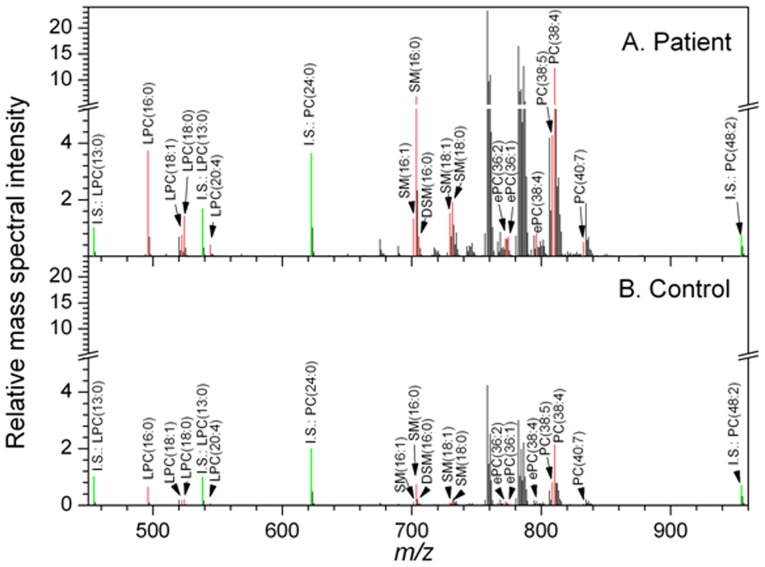
Mass spectra of phosphocholine-containing lipids (Pre-184 positive mode, including biomarker species.A: Spectra of 15 selected apparent lipid species in a representative patient with prostate cancer. B: Spectra of 15 selected apparent lipid species in a representative male control. Spectral intensities were normalized to that of internal standard LPC(13∶0). The intensities of phosphocholine-containing internal standards (I.S.) are indicated in green. The intensities of the identified biomarkers are shown in red. Internal standards and biomarkers (15 selected apparent lipid species) are labeled.